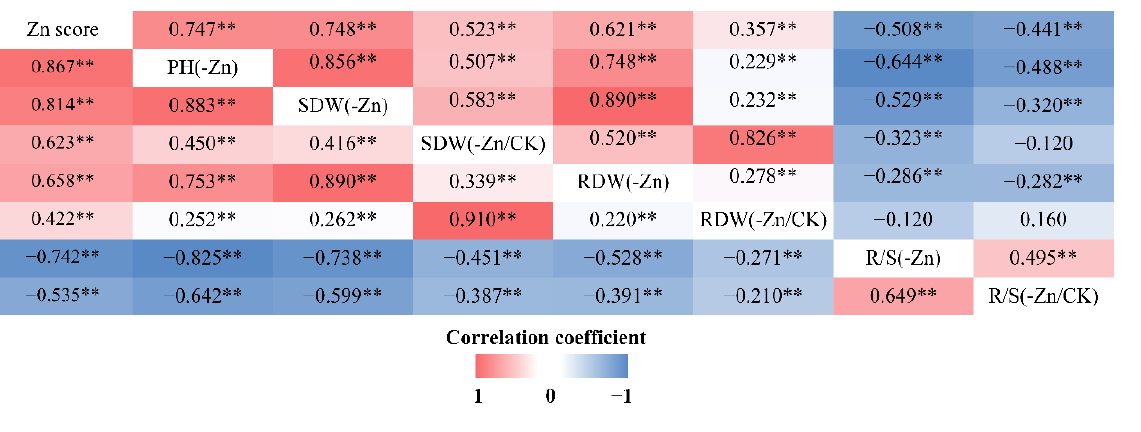
Figure 6. Correlation coefficients among eight traits in the K22×BY815 (upper triangular matrix) and DAN340×K22 (lower triangular matrix) RIL populations. PH, plant height; SDW, shoot dry weight; RDW, root dry weight; R/S, root-to-shoot ratio. **, p < 0.01.